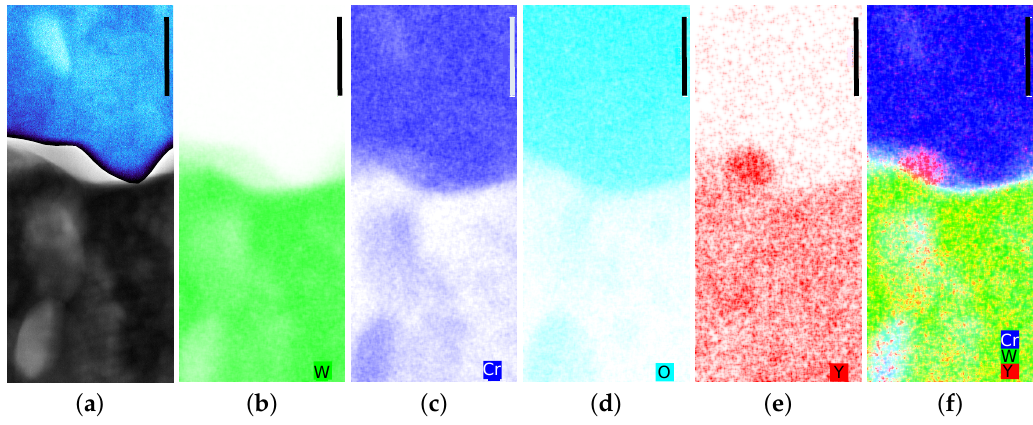
Figure 9. STEM measurement in region B from Figure 8a. The alloy W-12Cr-0.5Y is oxidized at a temperature of 1273K at 20kPa O 2 and 80kPa Ar partial pressure for 75min. The scale-bar in the top right corner has a length of 50nm for all images. ( a ) Electron image using two different color maps: One for the Cr 2 O 3 layer and one for the alloy; EDX map measurements of ( b ) tungsten; ( c ) chromium; ( d ) oxygen; and ( e ) yttrium; ( f ) Overlay of images ( b , c , e ). These data were already briefly introduced in ref.